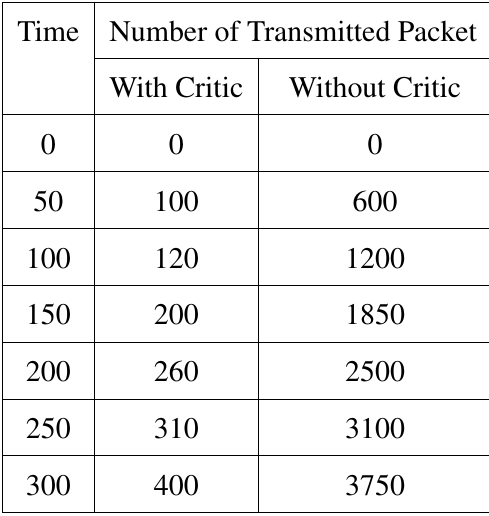
Table 1. The comparison of performance with and without the critic based adaptive sleeping